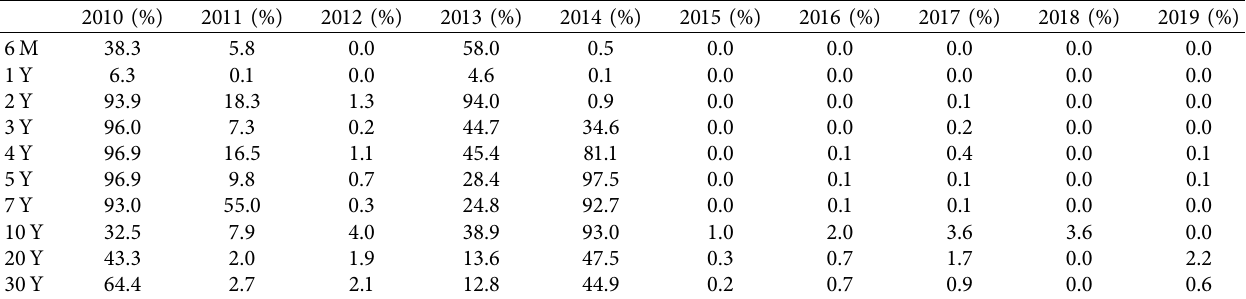
Table 4: p -values from the Wald test for the manufacturing sector.